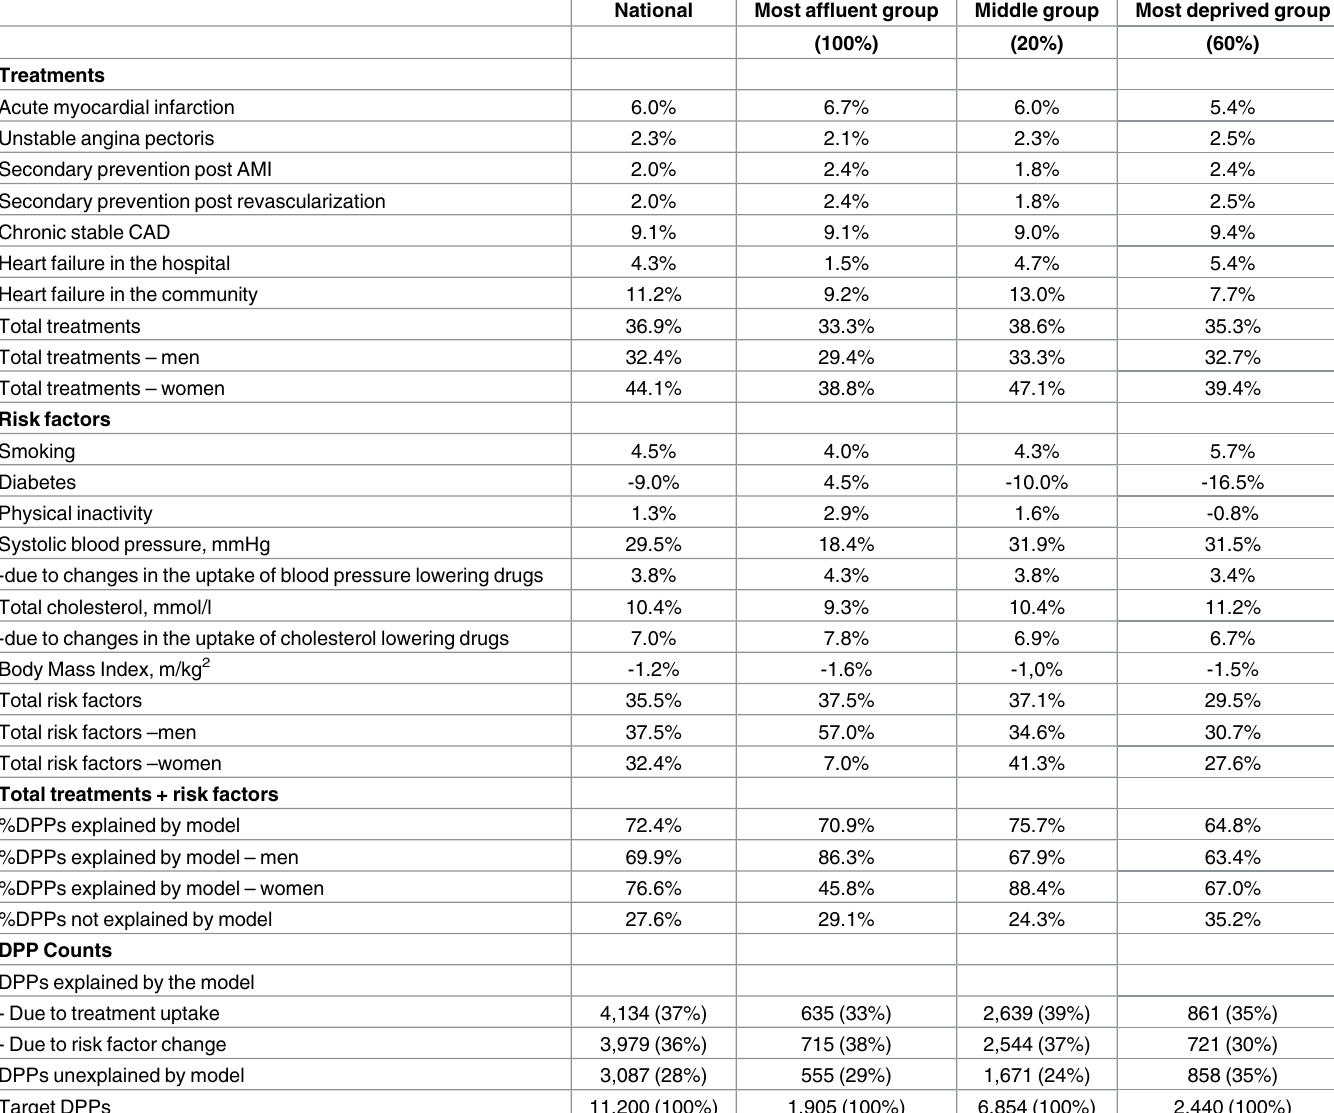
Table 3. Proportion of CHD deaths prevented or postponed by socioeconomic group, due to change in treatments and risk factors between 1997 and